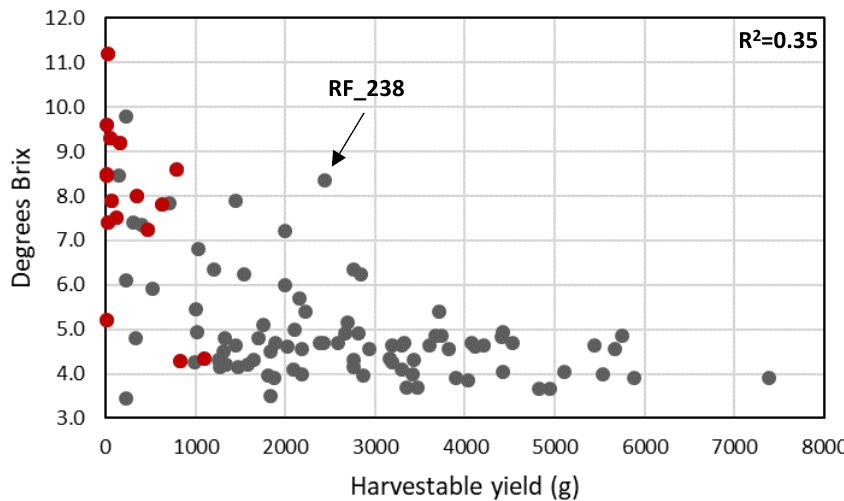
Figure 8. The relationship between Brix (soluble solids content) and harvestable yield. Black dots: cultivated tomato accessions; red dots: wild tomato relatives. The relative outlier RF_238 (see text) is indicated with an arrow.